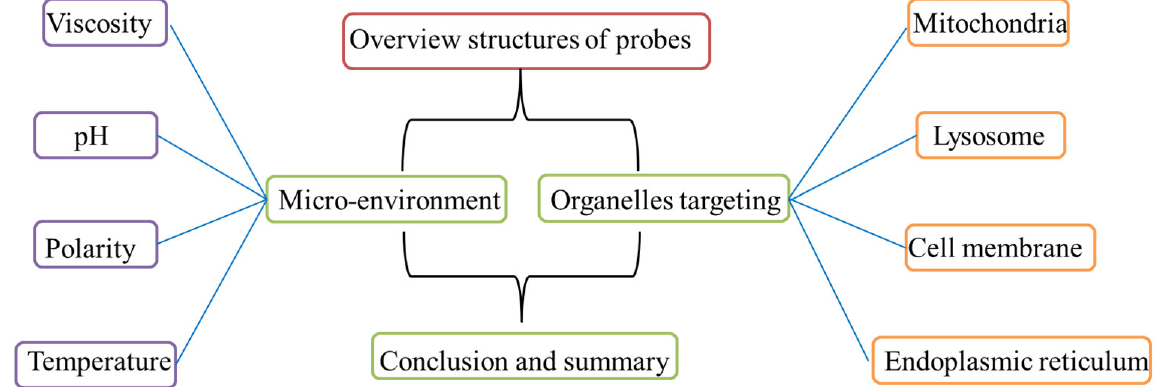
Figure 1. The description structures in this review.